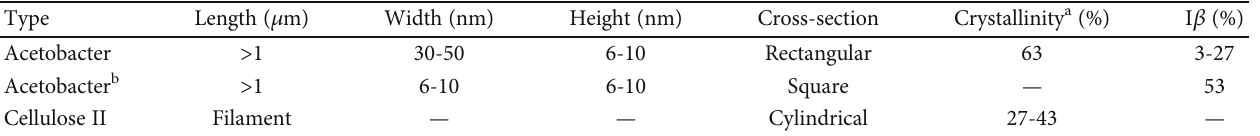
Figure 4: TEM of CNCs obtained from wood pulp using di ff erent pretreatments, (a) enzymatic, (b) TEMPO-mediated oxidation, and (c) carboxymethylation, and obtained from (d) Opuntia fi cus-indica [51]. Table 1: Comparison of BNC and cellulose